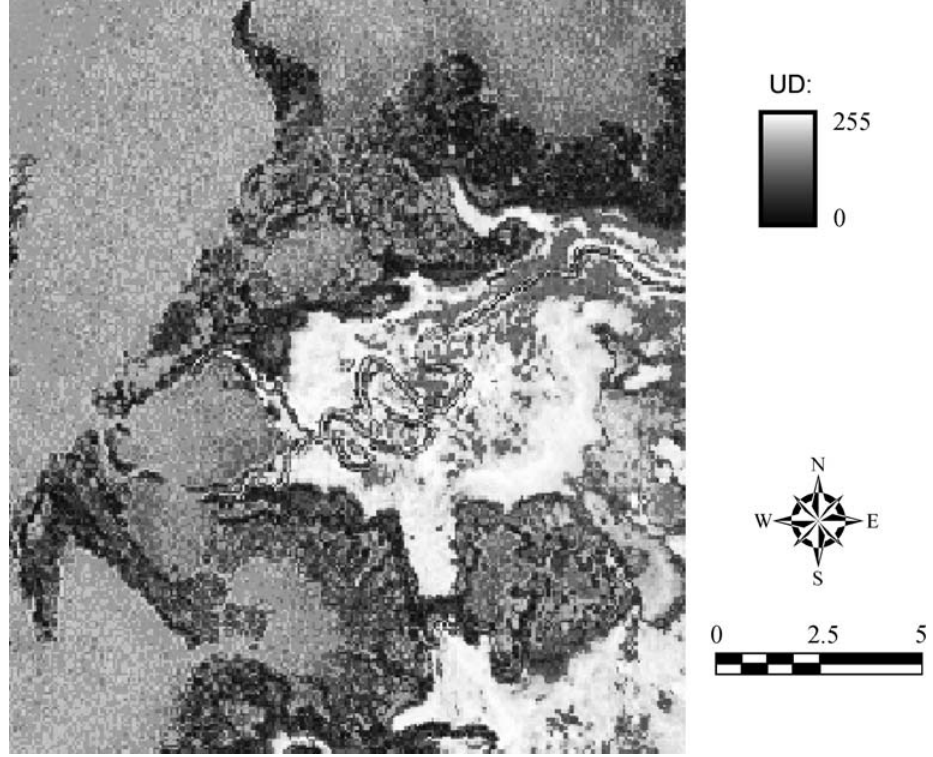
Figure 6. Spectral distance map (UD: digital units) of the mangrove class in relation to other